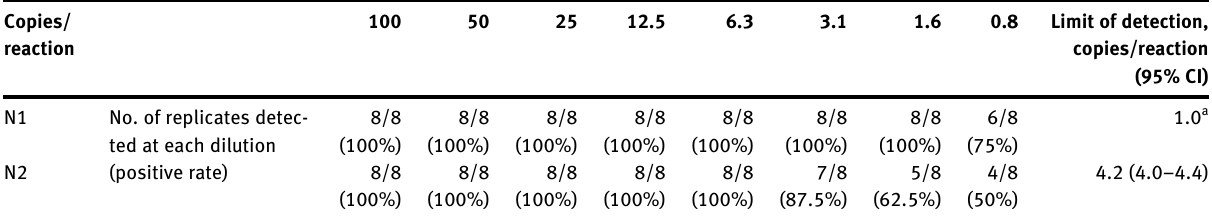
Table  : Detection limit of the SHIMADZU assay for SARS-CoV-  with serial dilutions of arti fi cially synthesized RNA. Copies/